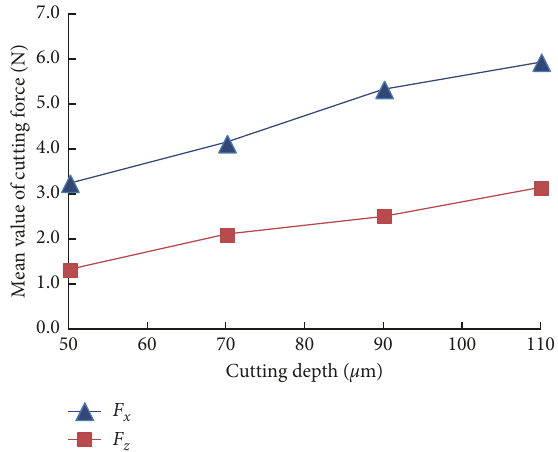
Figure 6: Mean value of the cutting force under different cutting